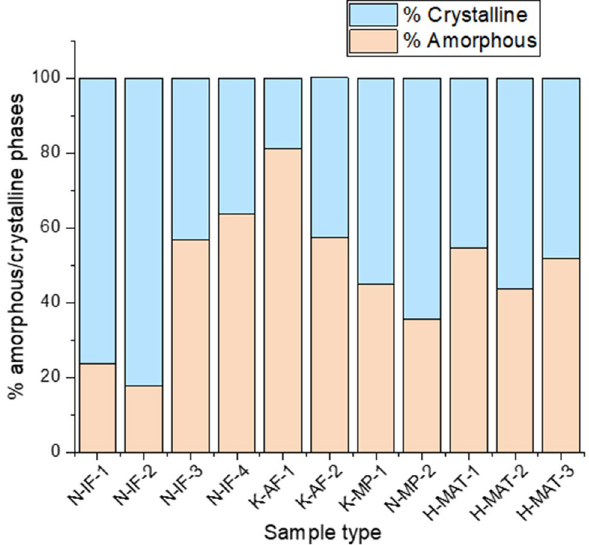
Figure 1. Index of crystallinity determined by XRD of selected samples found in a diversity of substrates, where previously the molecular distribution and stable-carbon isotopic composition of lipid biomarkers were determined 26 . IF: inactive fumarole, AF: active fumarole, MP: mud pot, MAT: microbial mat.